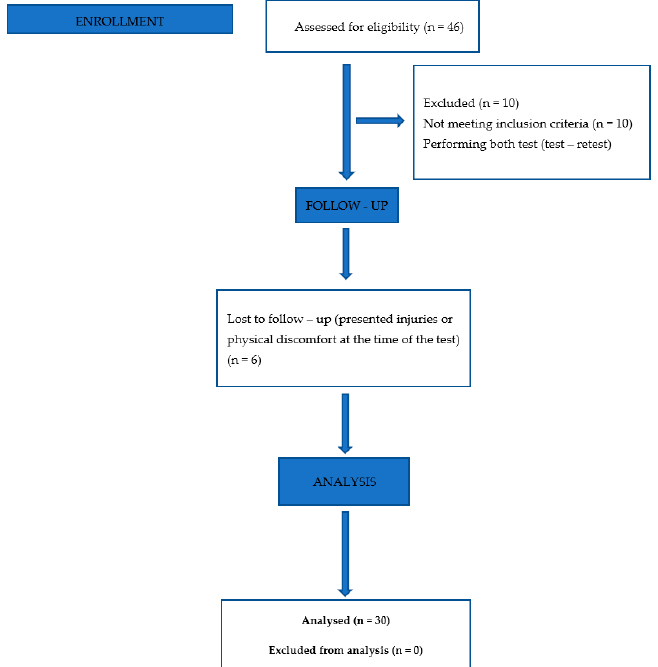
Figure 1. Flowchart: inclusion/exclusion criteria to obtain the sample of test participants.